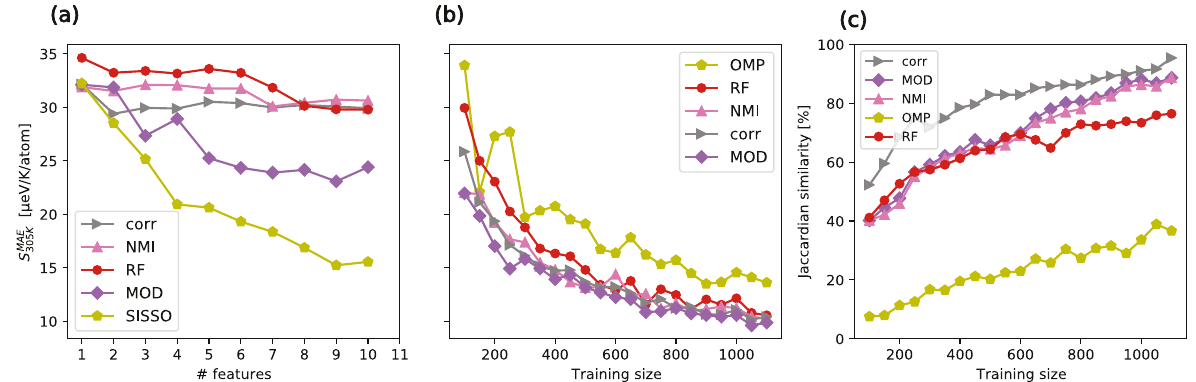
Fig. 5 Performance comparison of different feature selection methods. a Test error on the vibrational entropy at 305 K for different feature selection algorithms, as a function of the fi rst few features for 1100 training samples. b Test error on the vibrational entropy at 305 K for different feature selection algorithms as a function of the training size with other parameters being optimized over a fi xed grid. Models are constructed by replacing the selection algorithm in MODNet with a Pearson correlation (corr), normalized mutual information (NMI), random forest (RF), SISSO, and orthogonal matching pursuit (OMP). c Jaccardian similarity of the 300 fi rst selected features on a sampled training set of size n, and the total dataset (1245 samples) as a function of n , for different feature selection